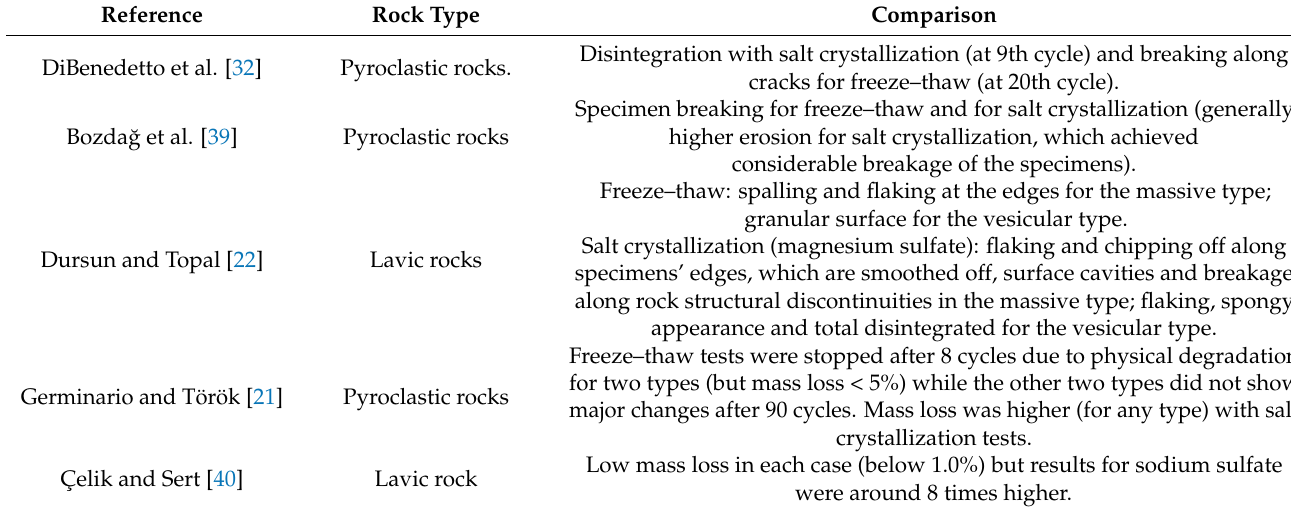
Table 2. Analysis of comparative studies of freeze–thaw tests and salt crystallization tests (sodium sulfate unless indications otherwise) on volcanic